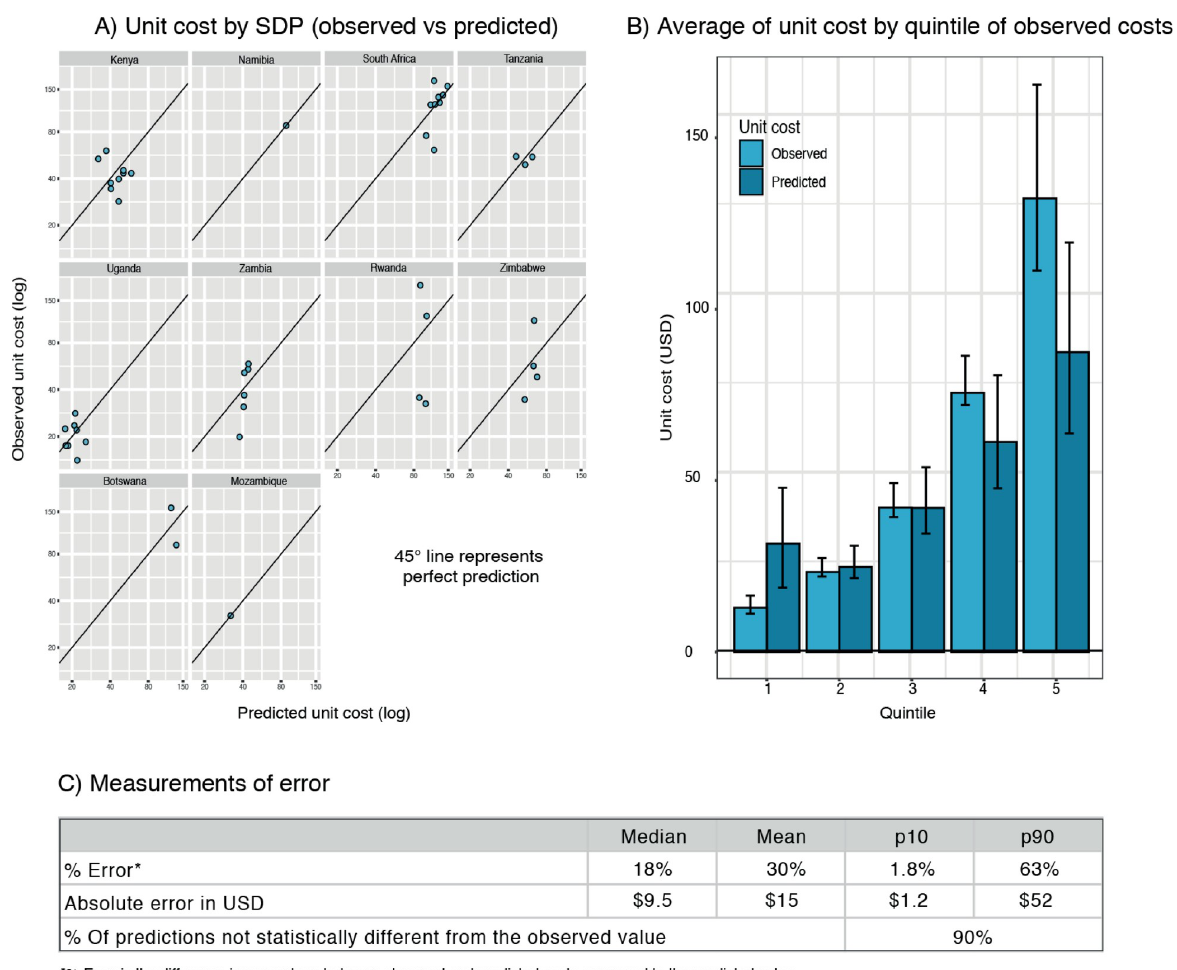
Fig 2. Validation of extrapolated VMMC unit